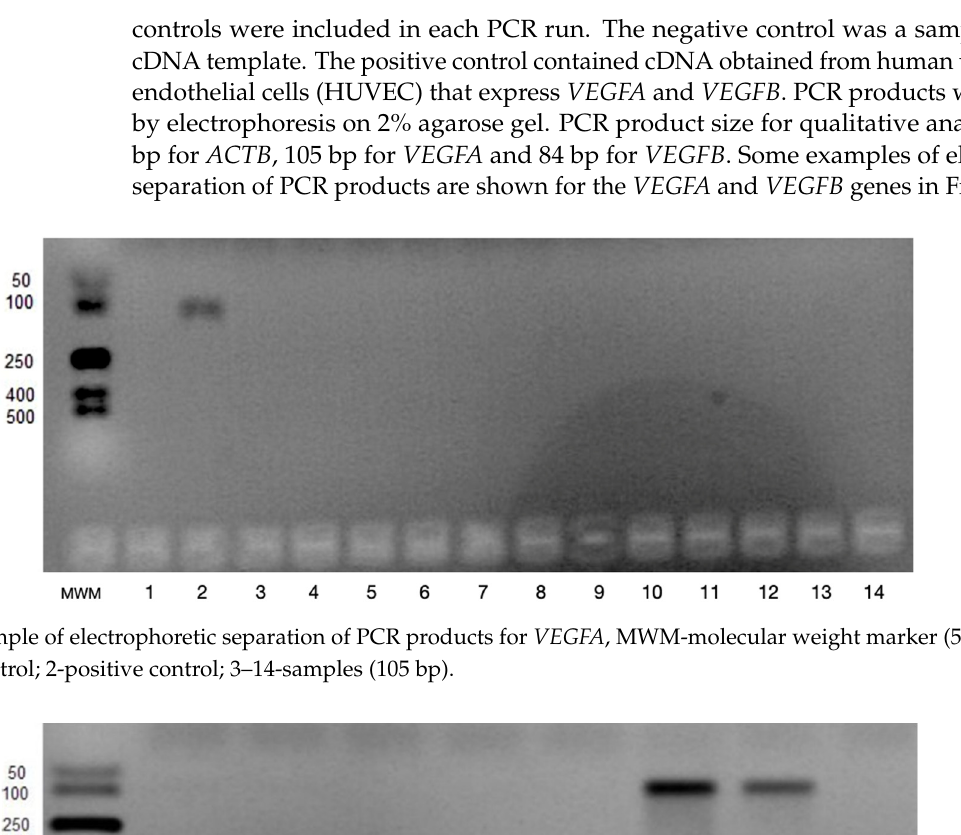
Figure 3. VEGF concentration in all groups of patients: group I (NSAIDs), group II (antibiotics), group II (NSAID and antibiotics) and control group (no drug treatment).